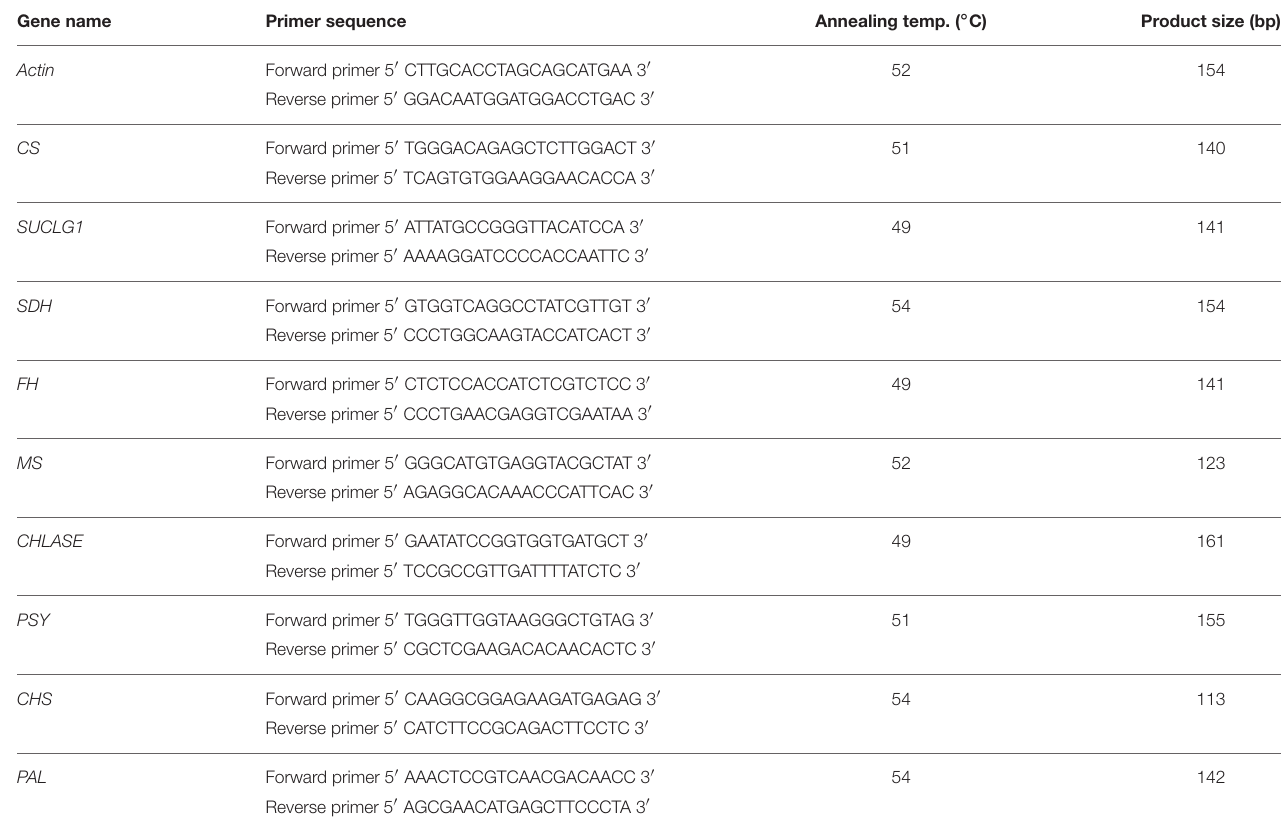
TABLE 1 | Primer sequences used for gene expression analysis using